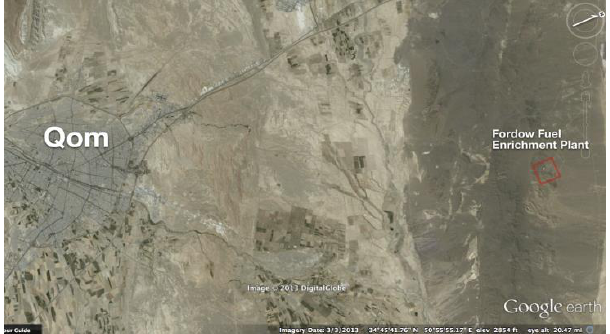
Figure 4. Google Maps